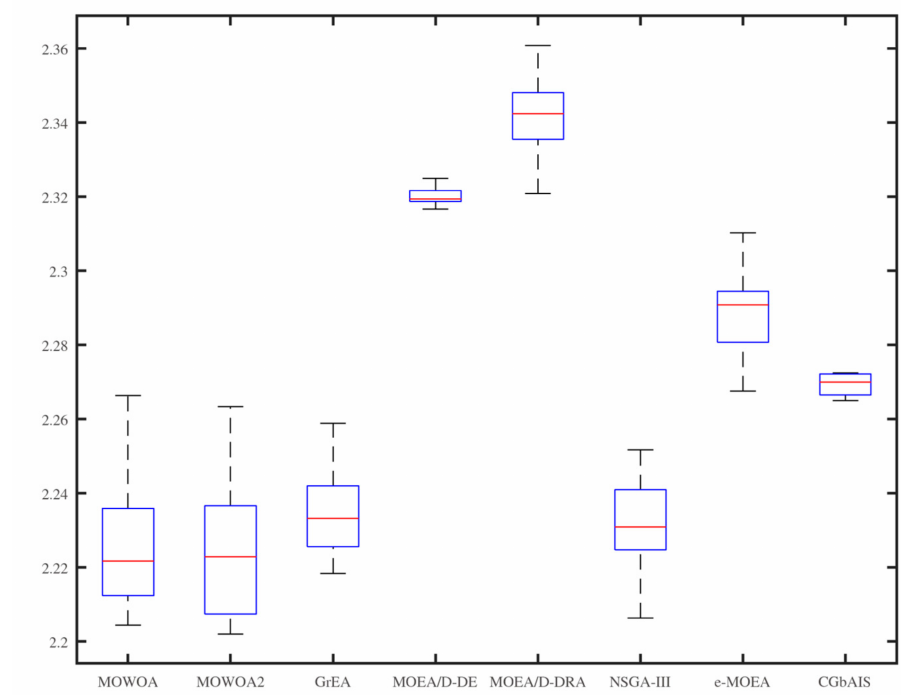
Figure 11. Time consumption of the different algorithms when the user number is